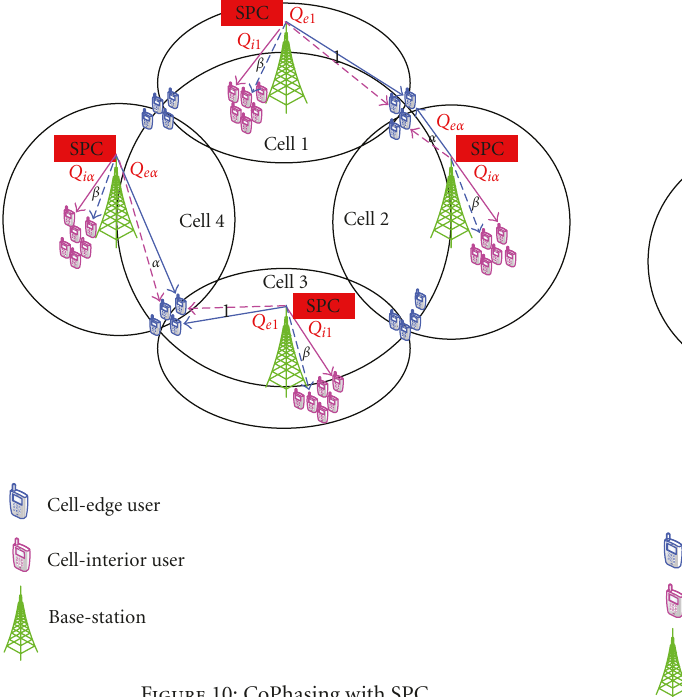
Figure 10: CoPhasing with SPC.